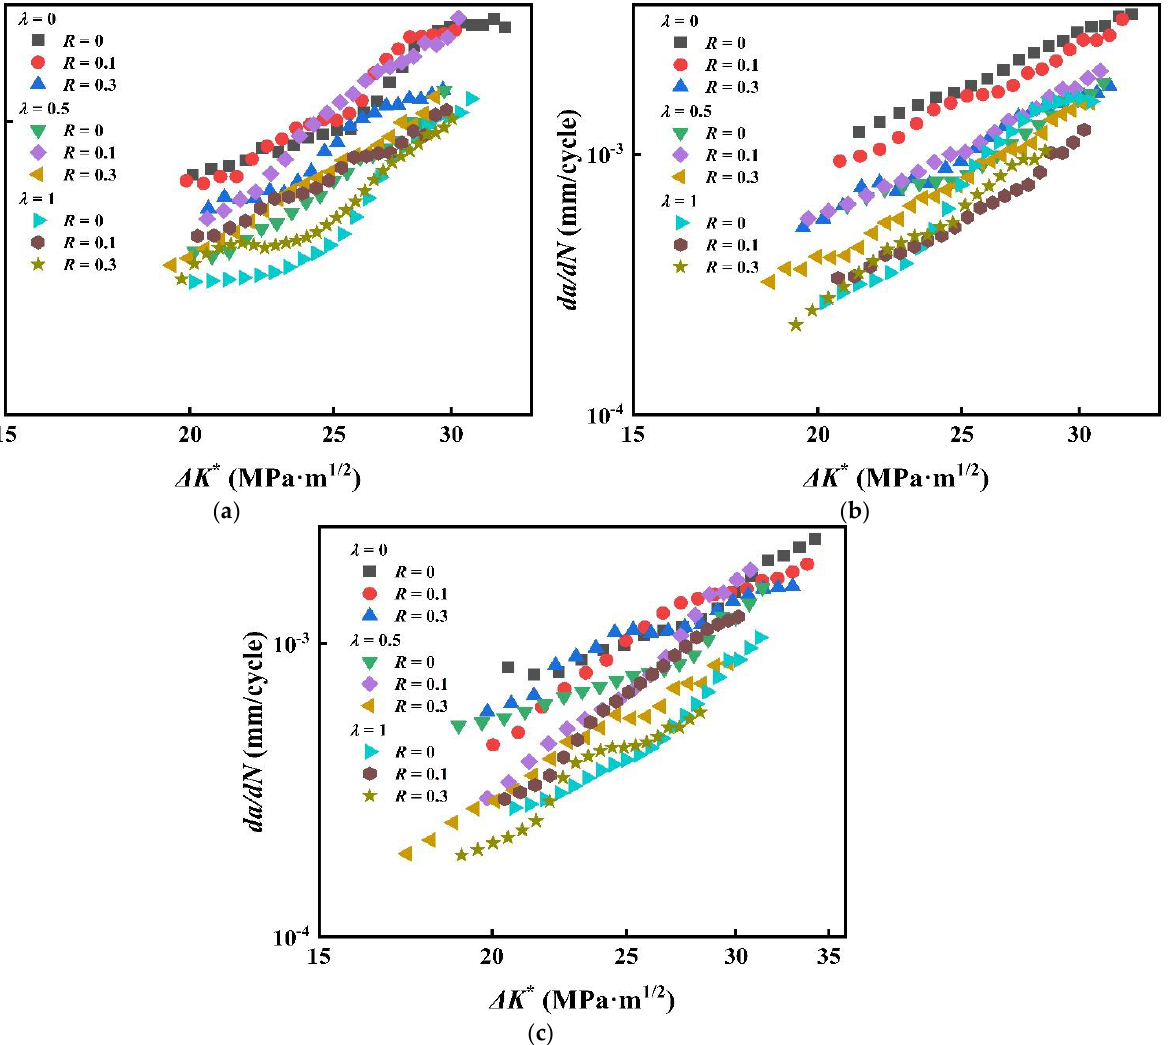
Figure 15. The relationship between ∆ K I and da / dN, based on the Kujawski model. ( a ) β = 90° ( b ) β = 60° ( c ) β = 45°.